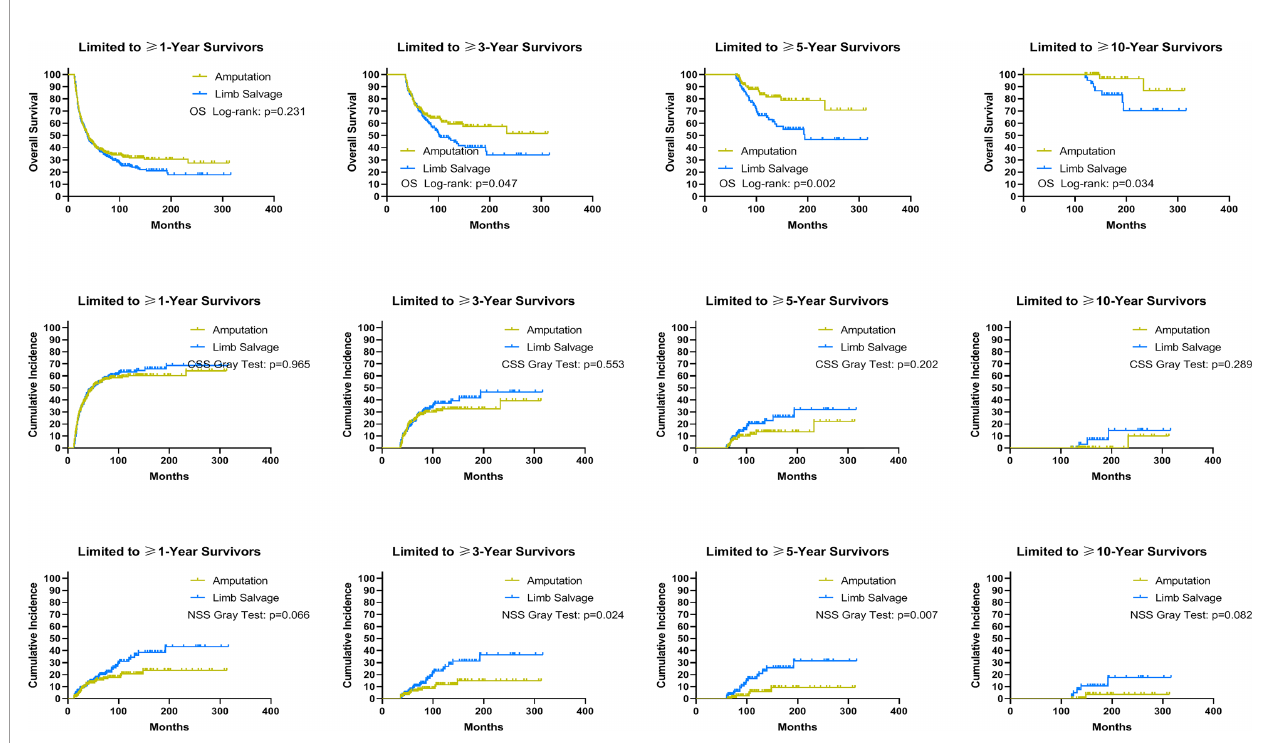
FIGURE 6 | Subgroup analysis: Landmark analyses of overall survival, cancer-speci fi c survival, and non-sarcoma survival for long-term survivors with advanced sarcomas in the cohort after PSM. PSM, propensity score-matched patients; OS, overall survival; CSS, cancer-speci fi c survival; NSS, non-sarcoma survival.